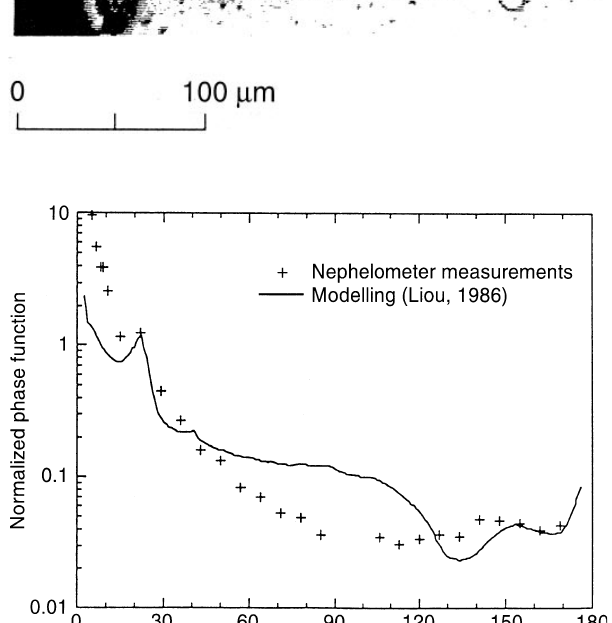
Fig. 16. Mean Scattering phase function measured by the Polar Nephelometer over 10 s during the sampling of ice crystals in the cold chamber. The theoretical curve relative to hexagonal ice crystals randomly oriented (Liou, 1986) is